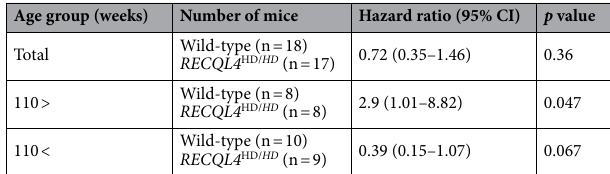
Figure 6. Comparative analysis of the delivery periods and lifespan among wild-type and tumor suppressor gene-deficient mice. Delivery periods between mating initiation and the 1st delivery ( A ) and between the 2nd or later delivery and the previous delivery ( B ). The mean number of days is indicated by the bars. p values were determined by the Mann–Whitney U test or Welch’s t-test. p53: p53 −/− , APC: APC Min/+ , RECLQ4: RECQL4 HD/HD . ( C ) Kaplan–Meier survival curves showing the lifespan of the wild-type C57BL/6 J (n = 18; 10 male, 8 female), p53 −/− (n = 19; 8 male, 11 female), APC Min/+ (n = 19; 12 male, 7 female), and RECQL4 HD/ HD (n = 17; 11 male, 6 female) mouse strains. p values were determined by the Gehan-Breslow-Wilcoxon test. ( D ) Representative images of hematoxylin–eosin (H&E) staining of thymic lymphoma and splenomegaly in p53 −/− mice. Thymic lymphoma was indicated by a faint cytoplasm and convoluted nuclear contours, and splenomegaly was indicated by less-defined lymphoid follicles. ( E ) Cumulative mortality risk in wild-type mice and RECQL4 HD/HD mice. A Cox regression analysis was used to estimate the hazard ratios (95% confidential interval) of the age-dependent groups of RECQL4 HD/HD mice with those of wild-type mice, as shown in Table 1. ( F ) The rate of food intake (gram per hour) for the wild-type, p53 −/− , APC Min/+ , and RECQL4 HD/HD strains was calculated as described in Materials and Methods and is depicted in the box ‐ and ‐ whisker plot showing the medians of n > 35 samples, the first and third quartiles (boxes) and the overall ranges (whiskers). Ordinary one- way ANOVA for multiple comparisons among the four strains generated a p value of 0.29.